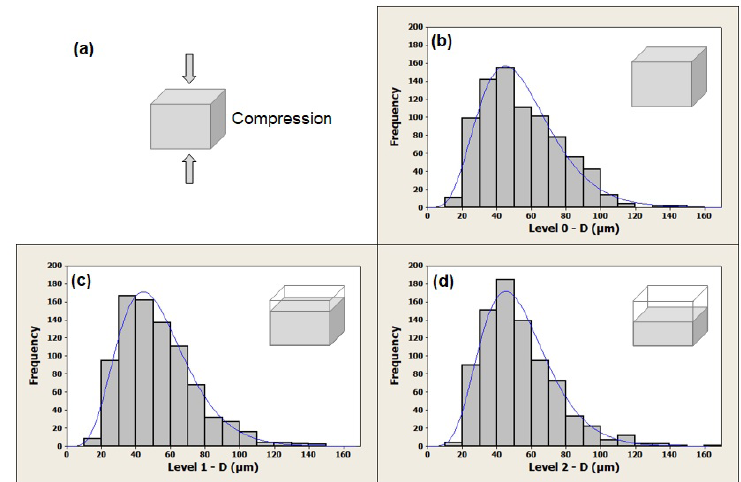
Figure 4. Distribution of grain sizes at different depths of pure ZA27 alloy: (a) The arrow indicates the compression direction, (b) level 0 (surface), (c) level 1 (0.15 cm below surface) and (d) level 2 (0.30 cm below surface).